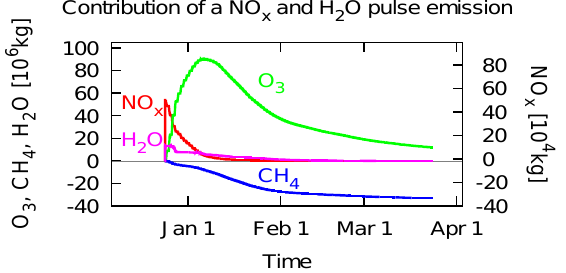
Fig. 7. Contributions from NO x and H 2 O emissions in a time region (here: 75 ◦ W, 30 ◦ N; 200hPa; 23 December, 06:00UTC) to NO x (red), ozone (green), methane (blue) and water vapour (magenta) global atmospheric masses